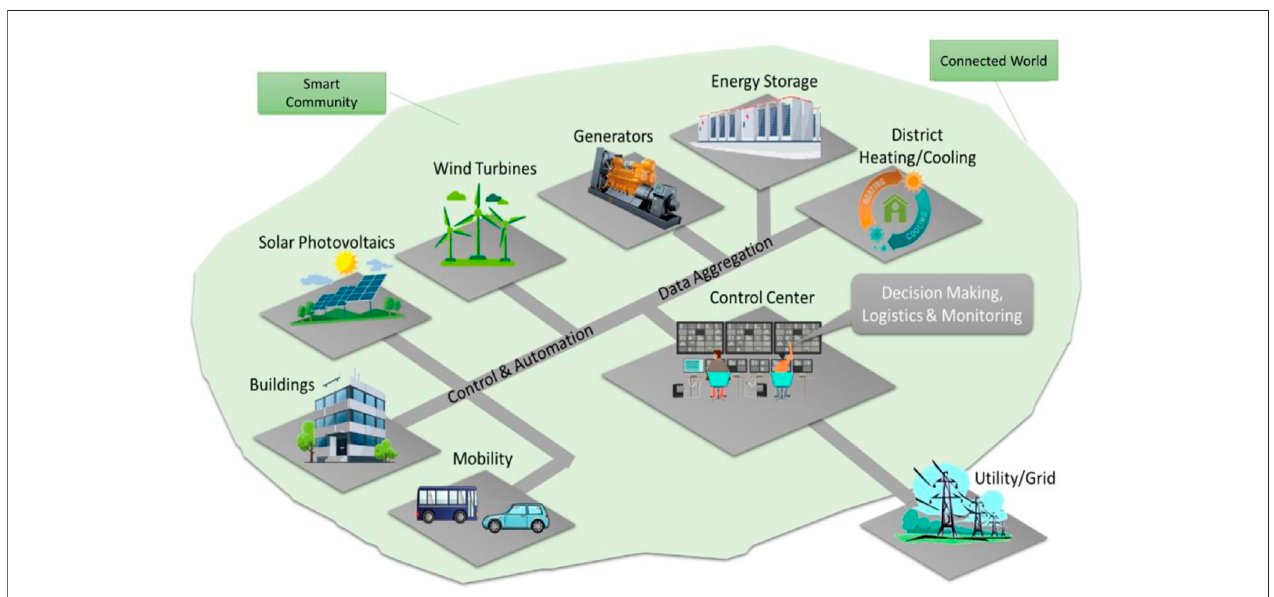
FIGURE 1 | High-level architecture in a smart